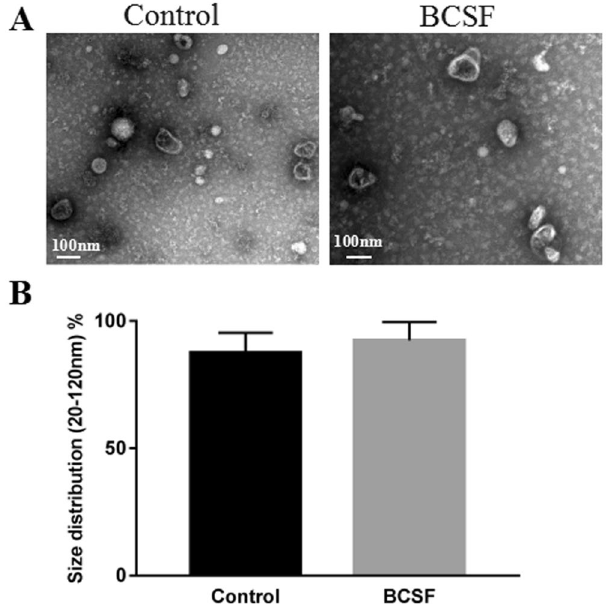
Figure 3. Morphological characterization of the exosomes. ( A ) Representative transmission electron microscopy image of normal cell culture medium and BCSF treated cell culture medium derived exosomes, showing a typical “saucer-like” morphology (scale bar, 100 nm). ( B ) Analysis of exosome size indicated similar particle size distribution between control group and BCSF group and > 85% isolated exosomes displayed a diameter of 20–120